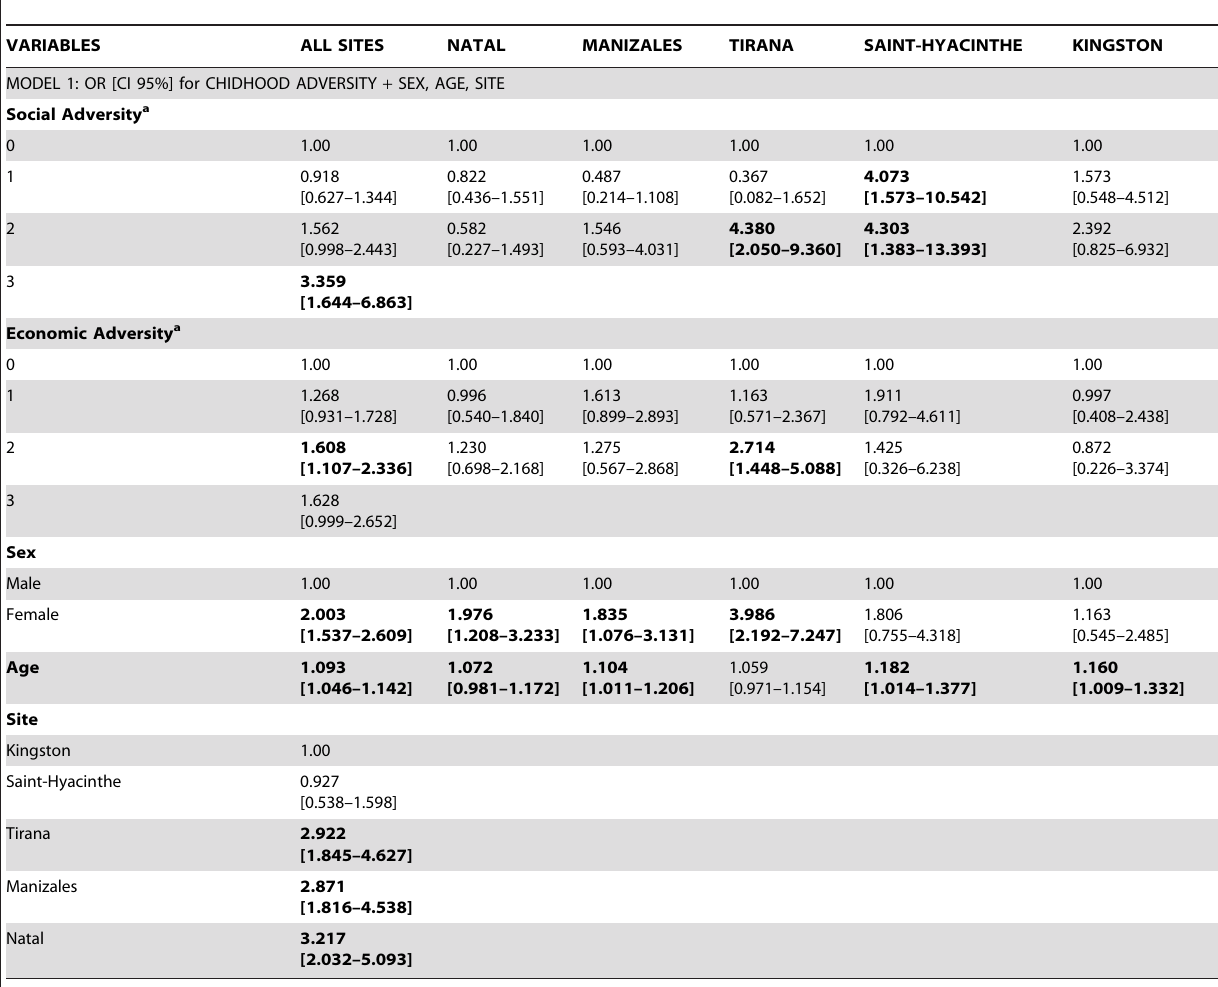
Table 3. Associations between Childhood Adversity and Poor Physical Performance (SPPB ,